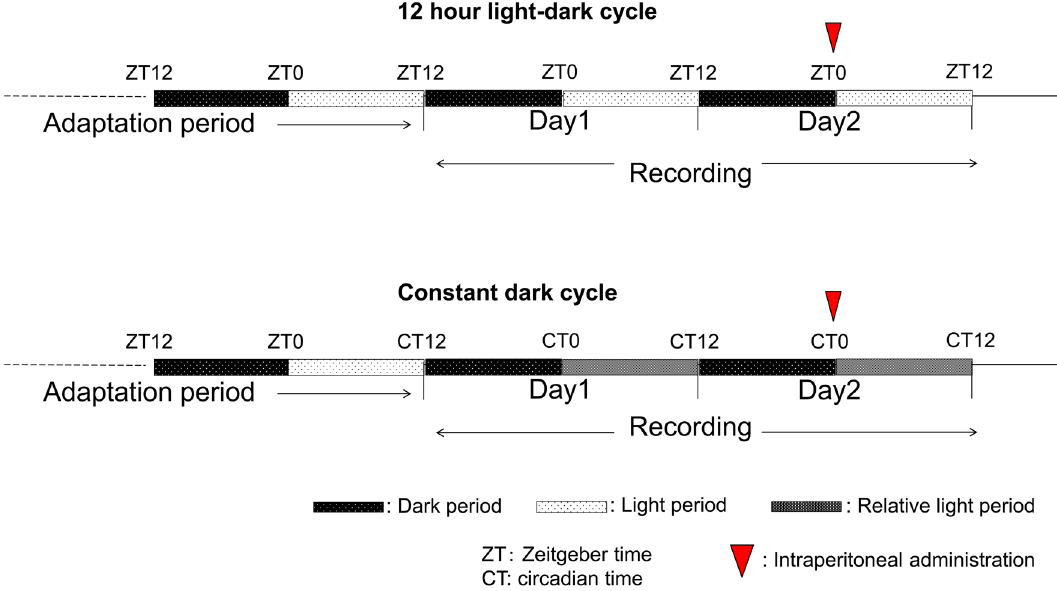
Figure 5. Time-course of intraperitoneal injection and recording of voiding